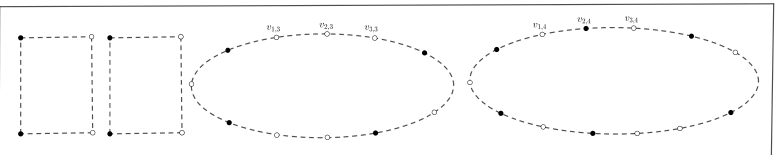
Figure 6. H 32 = 2 B 4 + B 11 + B 13 with its nr